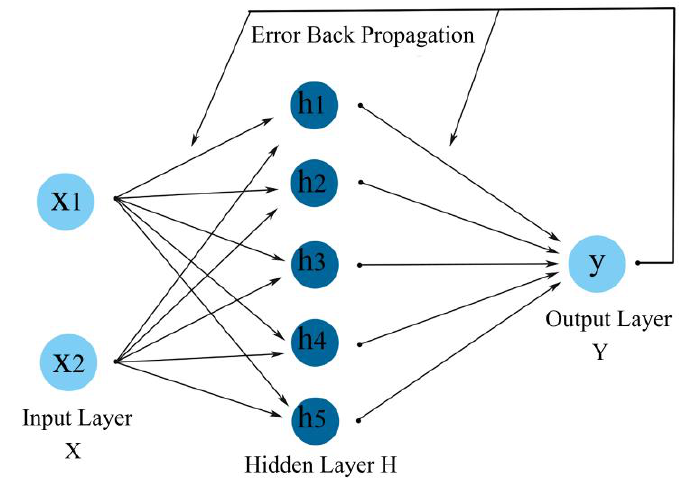
Figure 12. Schematic of a neural network.